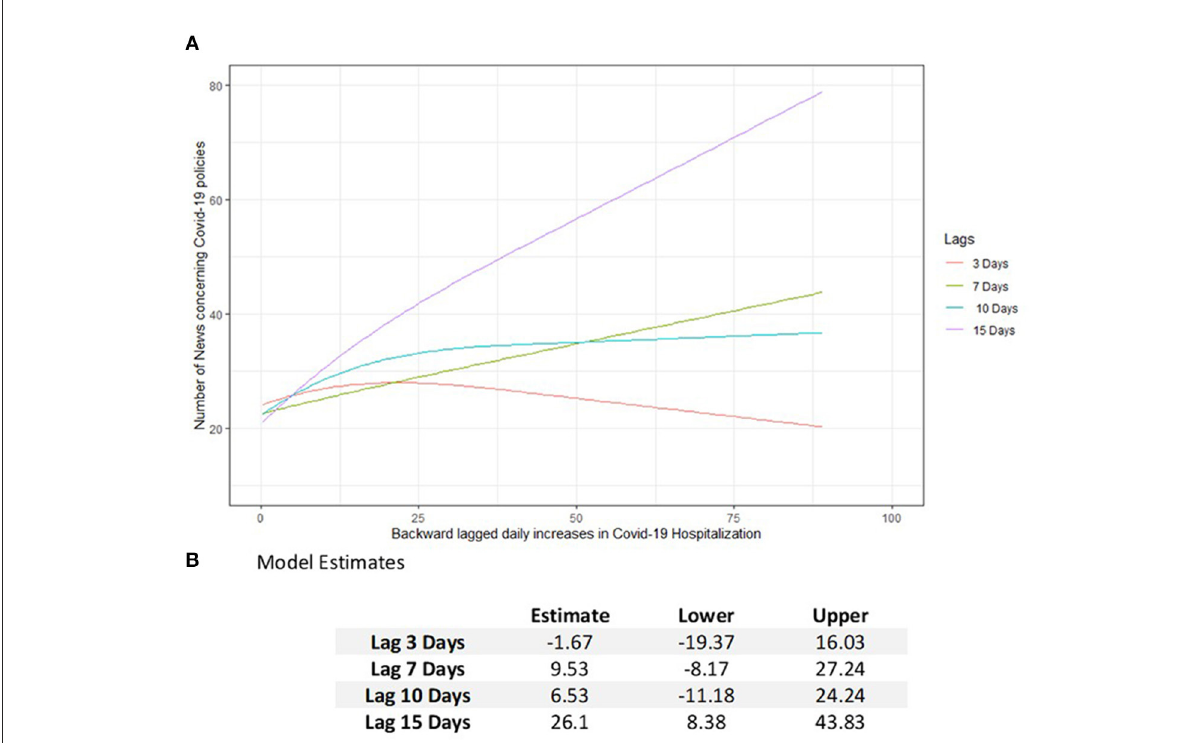
FIGURE2 Estimated number of news about the COVID-19 policies (A) in Veneto according to daily increases in the number of hospitalizations lagged backward by 3, 7, 10, and 15 days. (B) Model estimation table reporting the increasing effects in the number of COVID-19 policies with 95% CI subsequently to an increase of hospitalizations in the past days from 10 to